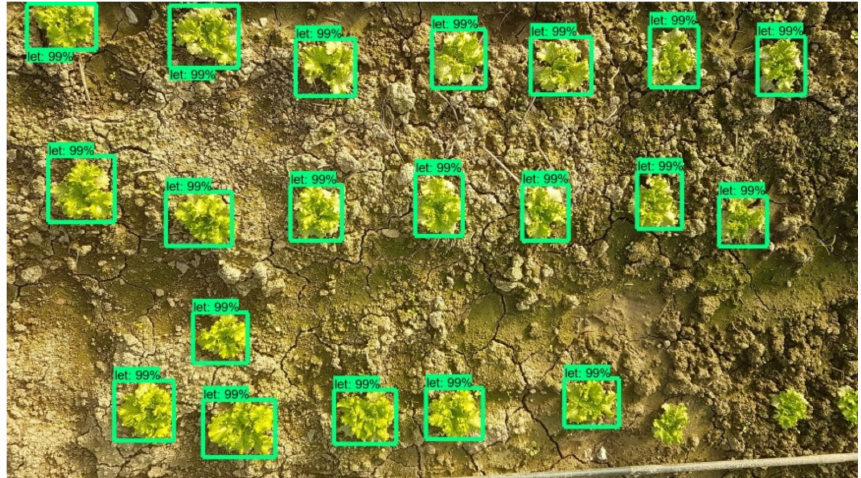
Figure 17. Plant detection and localization example in lettuce plants of early growth stages. CityVeg was unable to detect the bottom right lettuces which are the smallest ones in the